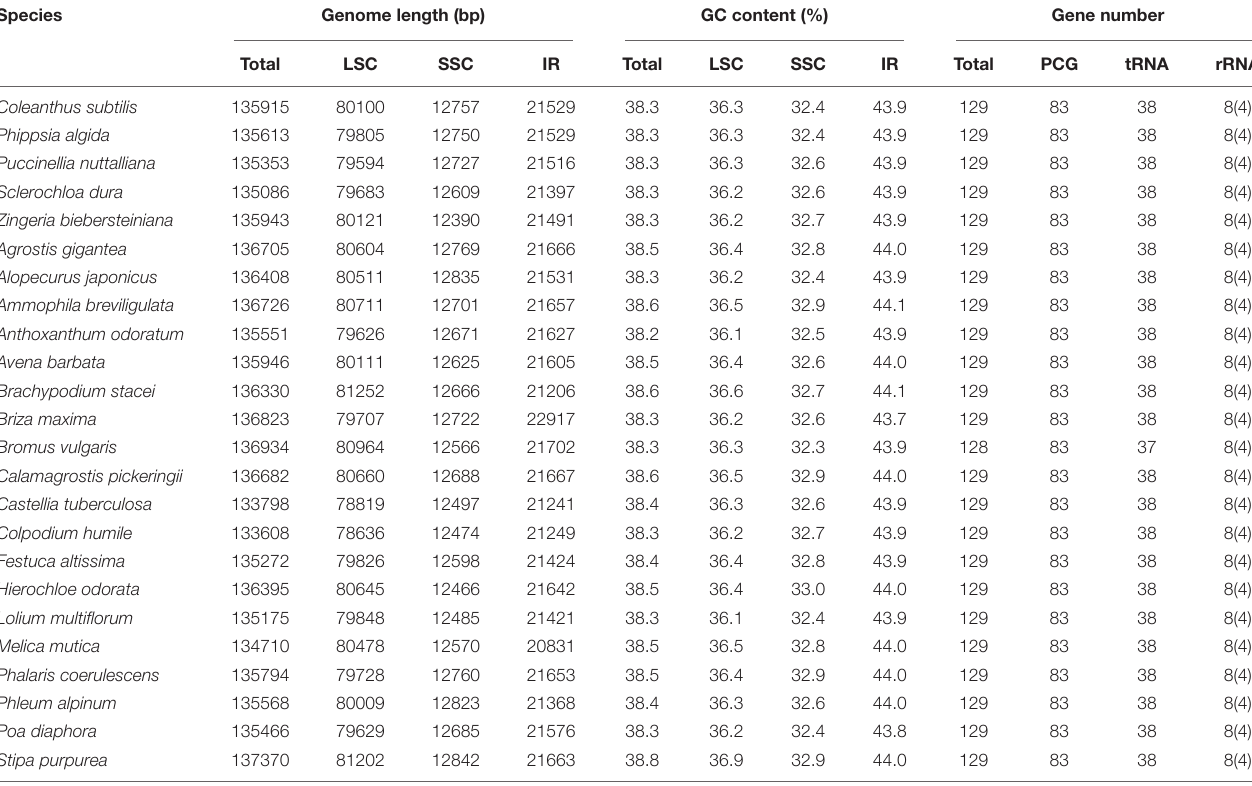
TABLE 1 | Features of the chloroplast genomes of C. subtilis and other Poaceae species. Species Genome length (bp)